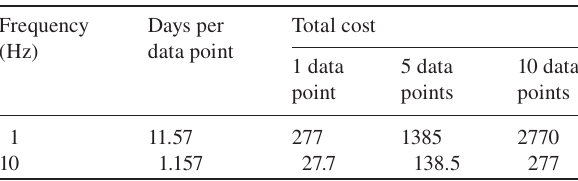
Table 1 Testing cost analysis at various frequencies. Total life: 10 6 cycles at $ 1/h.